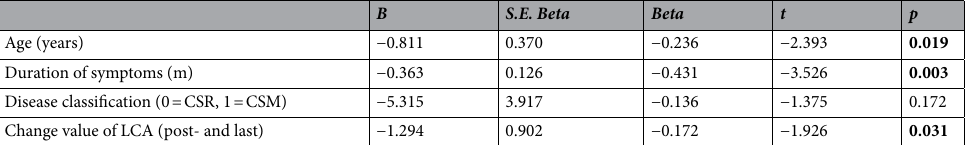
Table 2. Multiple linear regression model for predictive factors of recovery rate JOA score after ACDF. CSR cervical spondylotic radiculopathy, CSM cervical spondylotic myelopathy, LCA local Cobb angle. Significant values are in